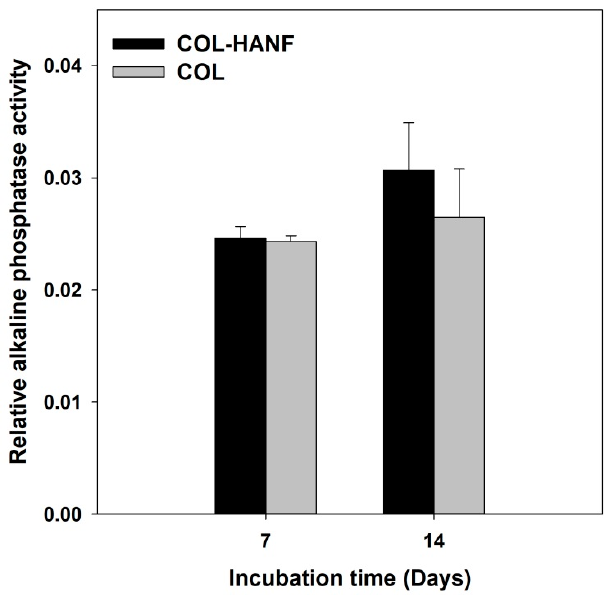
Figure 9. Relative ALP activity of MG63 cells on the COL and COL-HANF scaffolds for up to 14 days of culture. Data are presented as the mean ± SD, n = 3. Statistical analysis was performed to compare the COL and COL-HANF scaffolds. * represents significance at p < 0.05 by a nonparametric Mann-Whitney U test.